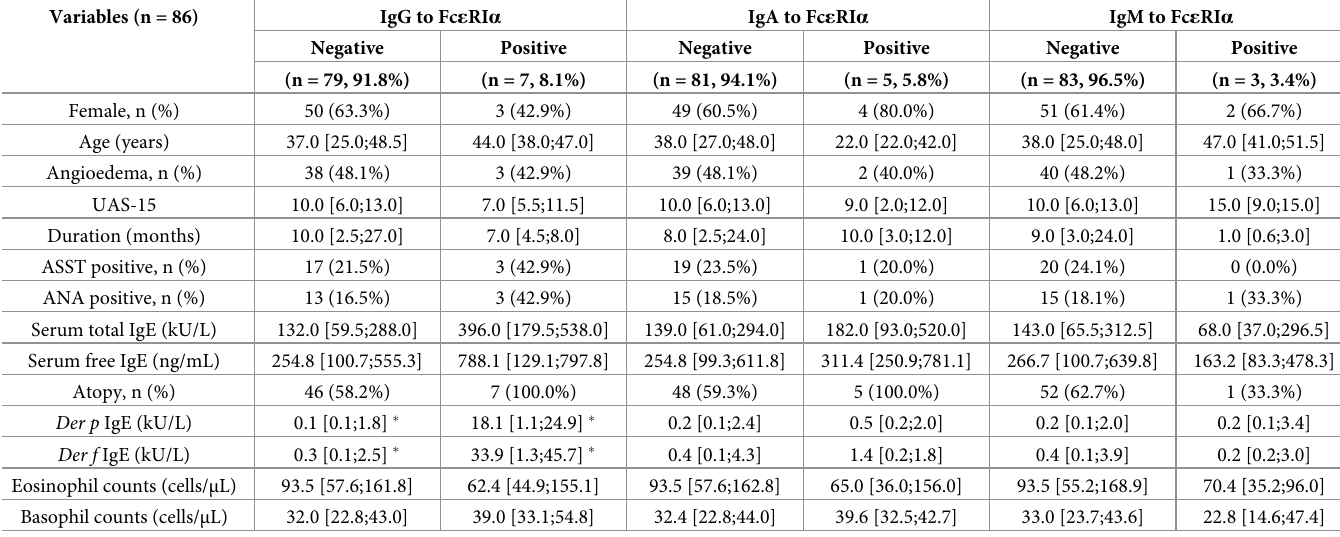
Non-parametric values are shown as median [IQR] and categorical values are shown as number (percentage). P values were evaluated by Pearson’s Chi-squared test or the Mann-Whitney test. � P < 0 . 05 , between patients with negative results and those with positive results to IgG to Fc ε RI α